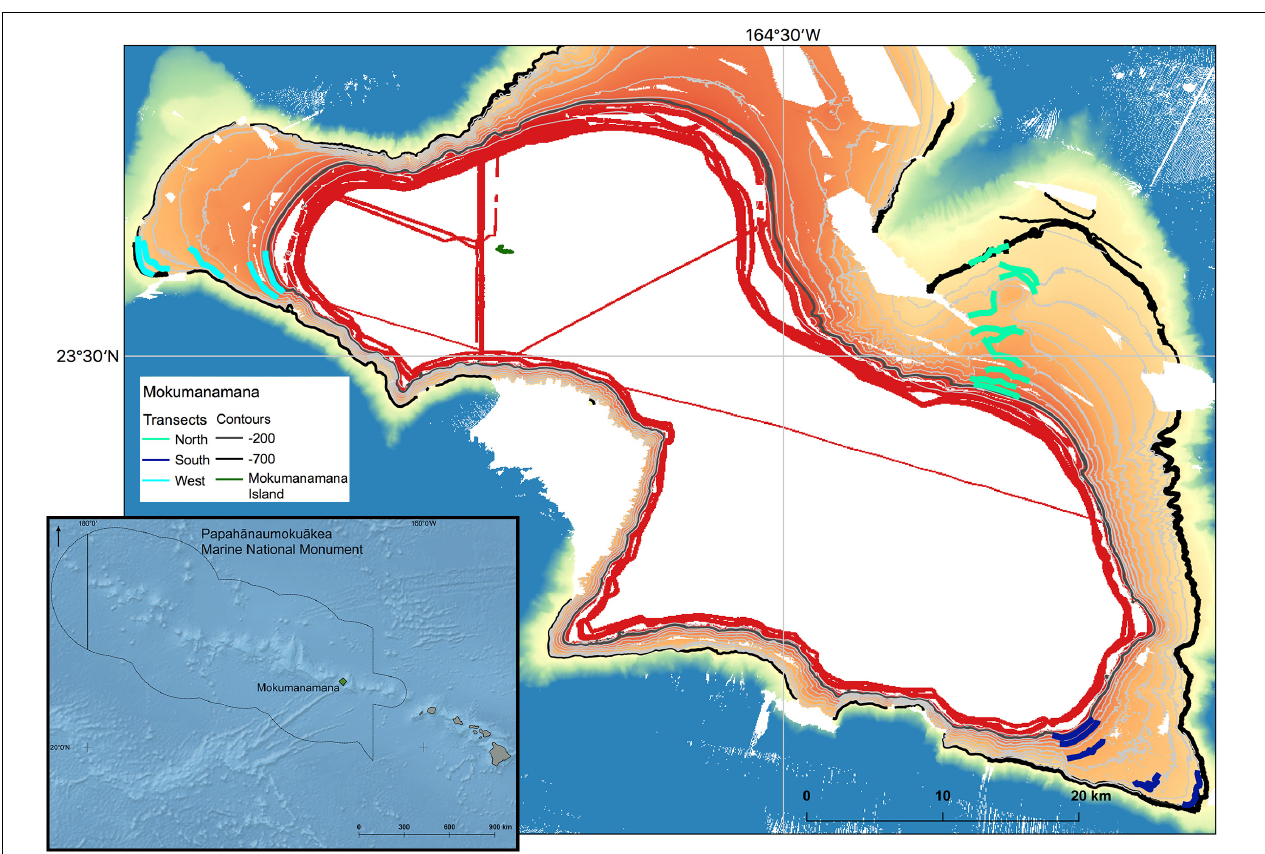
FIGURE 1 | Bathymetry of Mokumanamana with contours from 200–700 m at 50 m intervals shown. 200 and 700 m isobars are thick contours to highlight the depth range of the study. Transects lines on each of the three sides are plotted. Inset: Overview of the location of Mokumanamana (shown in green) within the Northwestern Hawai’ian Islands and Papahânaumokuâkea Marine National